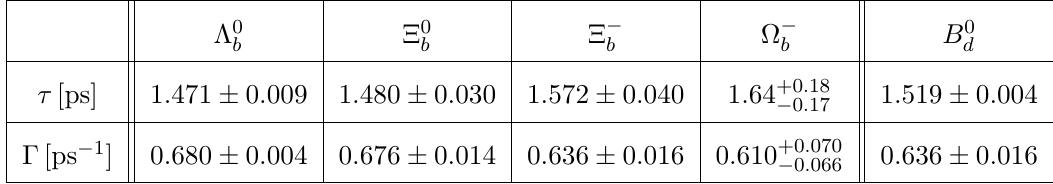
Table 1 . HFLAV averages of the experimental determinations of b -baryon lifetimes [57]. We also include the most recent value of the B 0 meson lifetime, which we use in our predictions for the d lifetime ratios with the baryons.